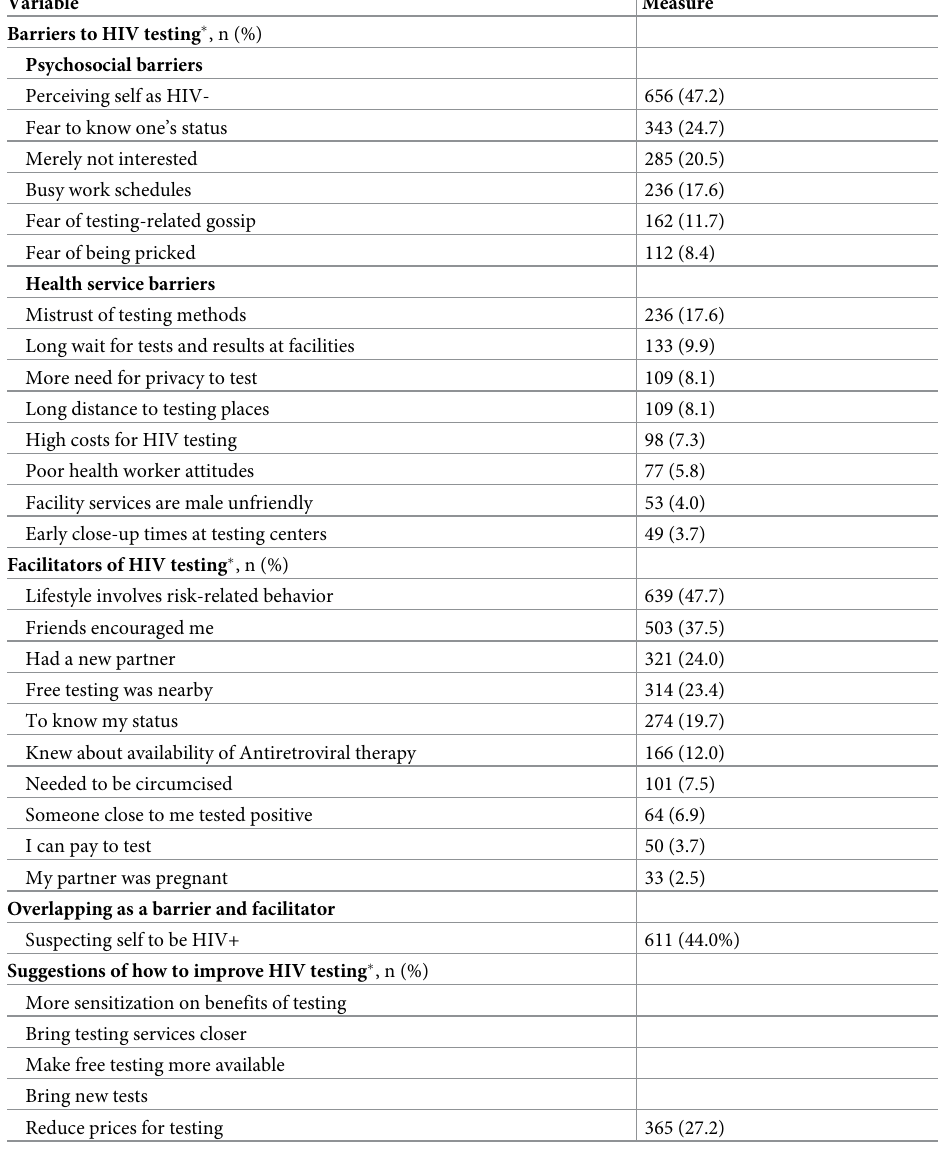
Table 4. Barriers, facilitators and views of how to improve HIV testing among male survey participants in Mpigi district, August to September 2018.